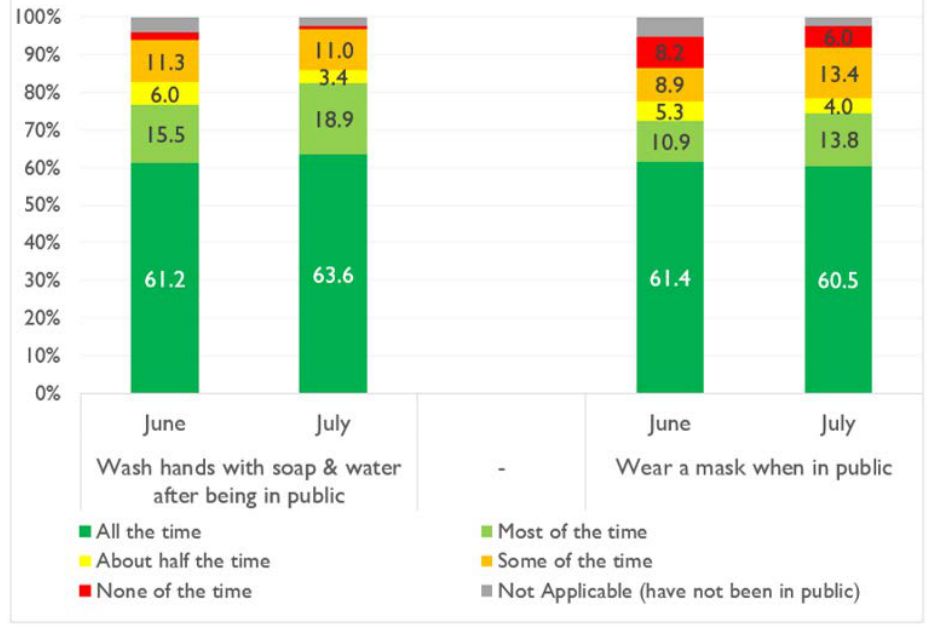
Figure 4. Safe practices in Nigeria from a World Bank study [22].